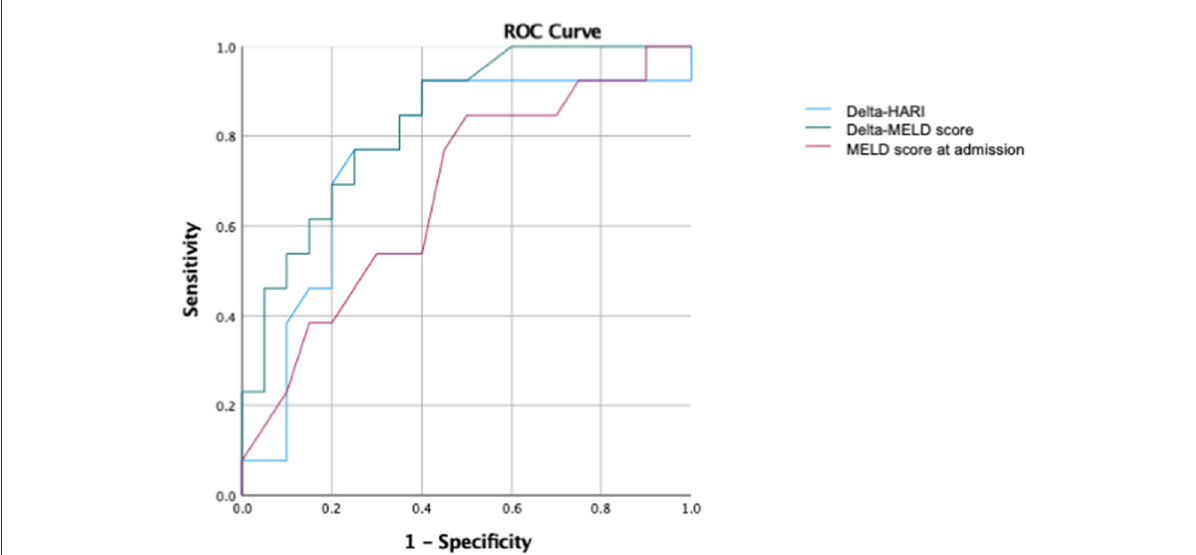
FIGURE5 ROC analysis for the prediction of ICU mortality. AUC of delta-HARI was 0.76 (95% Confidence Interval: 0.58–0.94, p = 0.012), AUC of delta-MELD was 0.84 (95% Confidence Interval: 0.70–0.97, p = 0.01), and AUC of MELD-Score at admission was 0.71 (95% Confidence Interval: 0.53–0.89, p = 0,049).